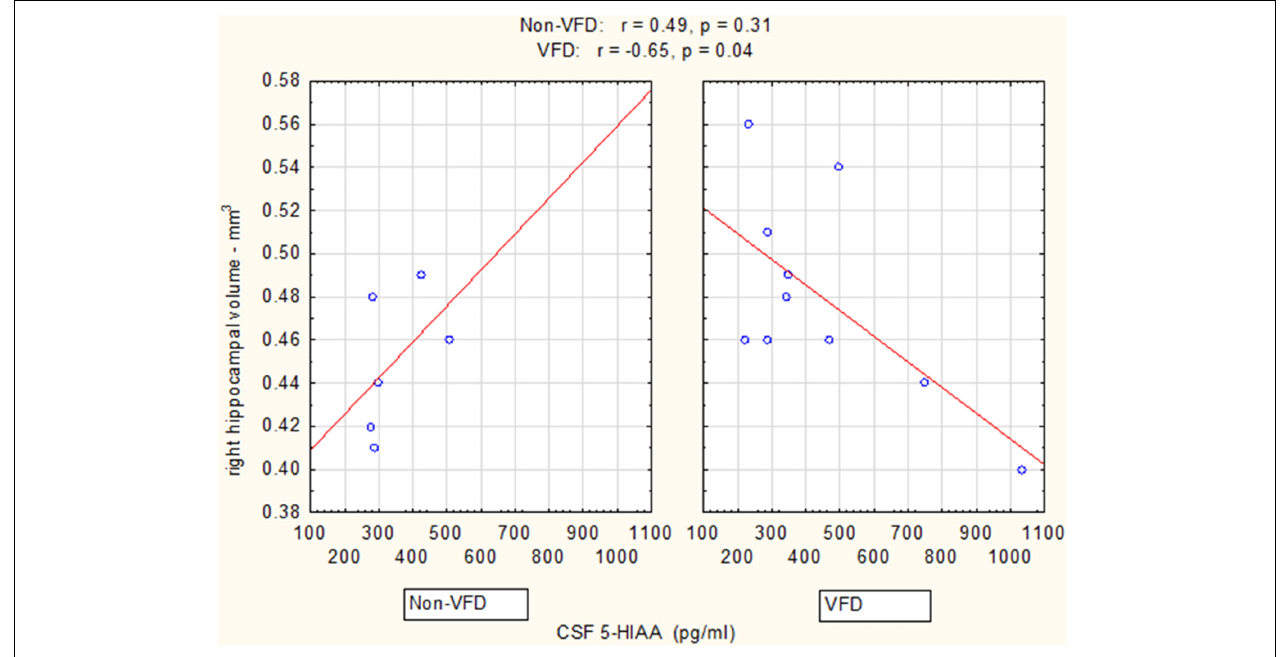
FIGURE 2 | Relationship between right hippocampal volume and CSF 5-HIAA as a function of early life stress. For CSF 5-HIAA, right hippocampus correlated inversely in VFD-reared subjects and but not in